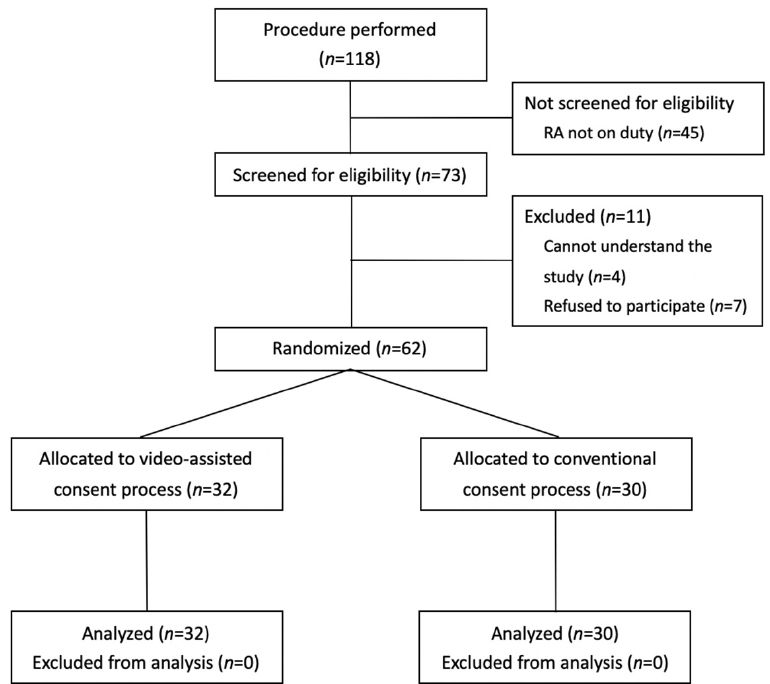
Figure 1. Randomized controlled trial flowchart. RA, Research associate.